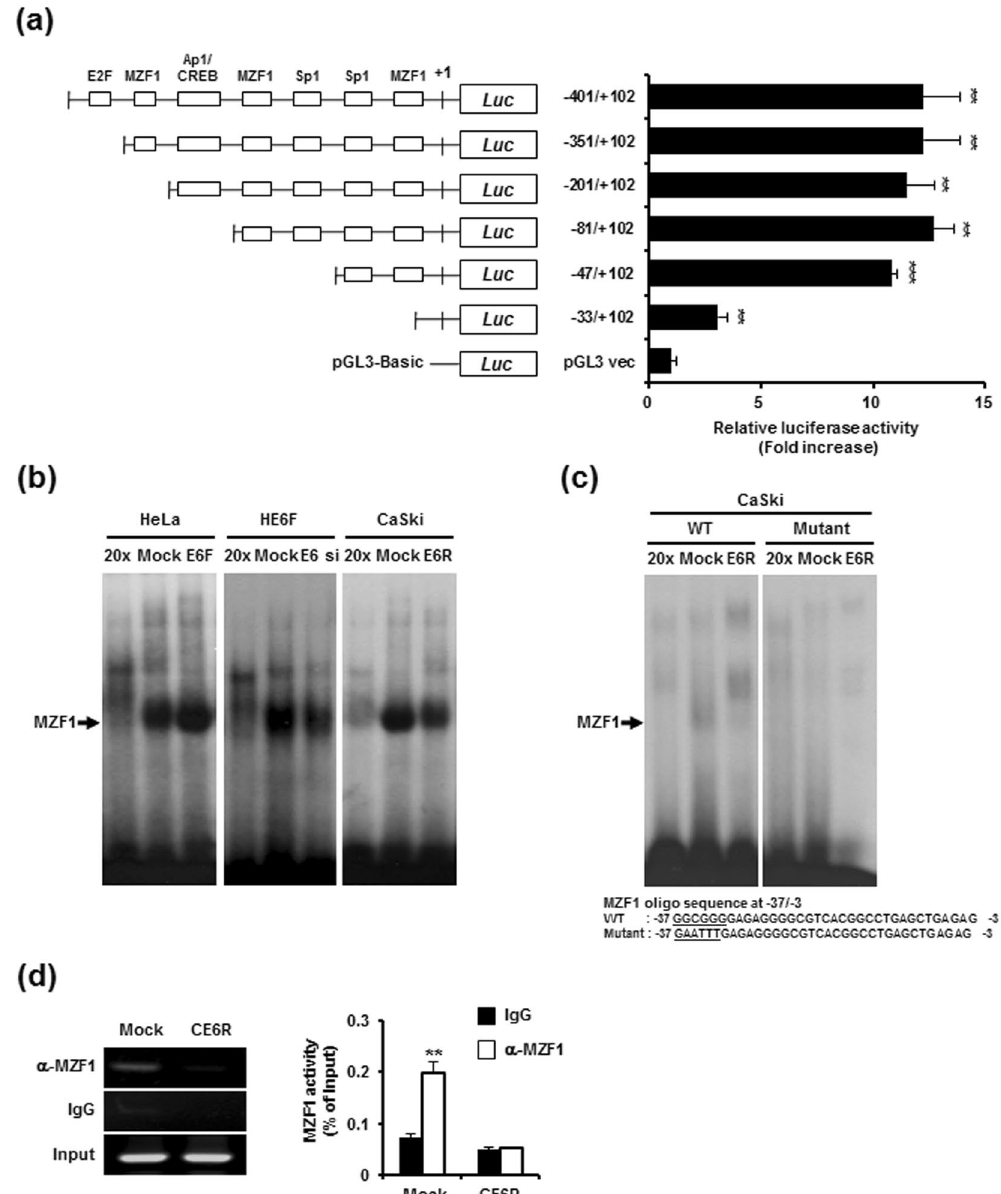
Figure 2. Transcriptional activation of MZF1 in the regulation of E6-mediated Axl expression. ( a ) Luciferase assays of lysates from 293 T cells following co-transfection with Axl promoter deletion constructs and a plasmid encoding HPV16E6 as indicated. Data are the mean ± s.e.m. from three independent experiments ( * P < 0.05; ** P < 0.01; *** P < 0.001). ( b ) MZF1 DNA binding ability was analysed by EMSA using nuclear extracts obtained from HE6F (left), E6-silenced HE6F (middle), and CE6R (right) cells and corresponding mock controls. Oct-1 was used as an internal control for equal protein loading. Cold 20 × contains a 20-fold excess of unlabelled MZF1 probe for competition analysis. ( c ) EMSA was done with oligonucleotides specific for MZF1 binding motif at − 37/ − 3 bp or with mutated sequence of MZF1. ( d ) DNA-protein complexes were immunoprecipitated from cross-linked chromatin using antibody specific for MZF1 and normal IgG control. The immunoprecipitated chromatin was subjected to PCR analysis using the indicated primers (left), and the binding activity was represented as a bar graph after calculating a relative percentage compared with corresponding levels in input DNA (right panel). The graphs represent the mean ± standard deviation of triplicate determinations ( ** P <